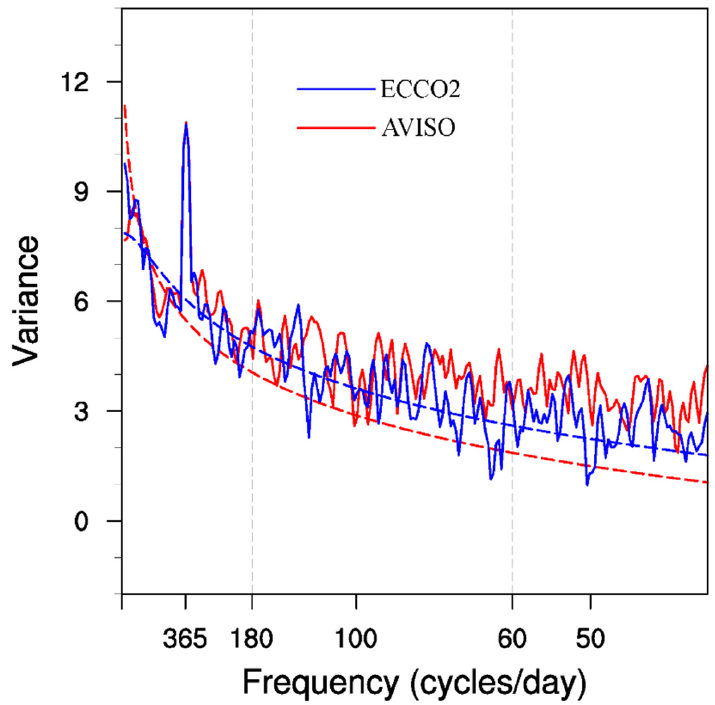
Figure 4. Variance-preserved power spectra as a function of periods of the sea surface height from AVISO (red line) and ECCO2 (blue line) data in the area of 150 − 160° E, 25 − 38° S.